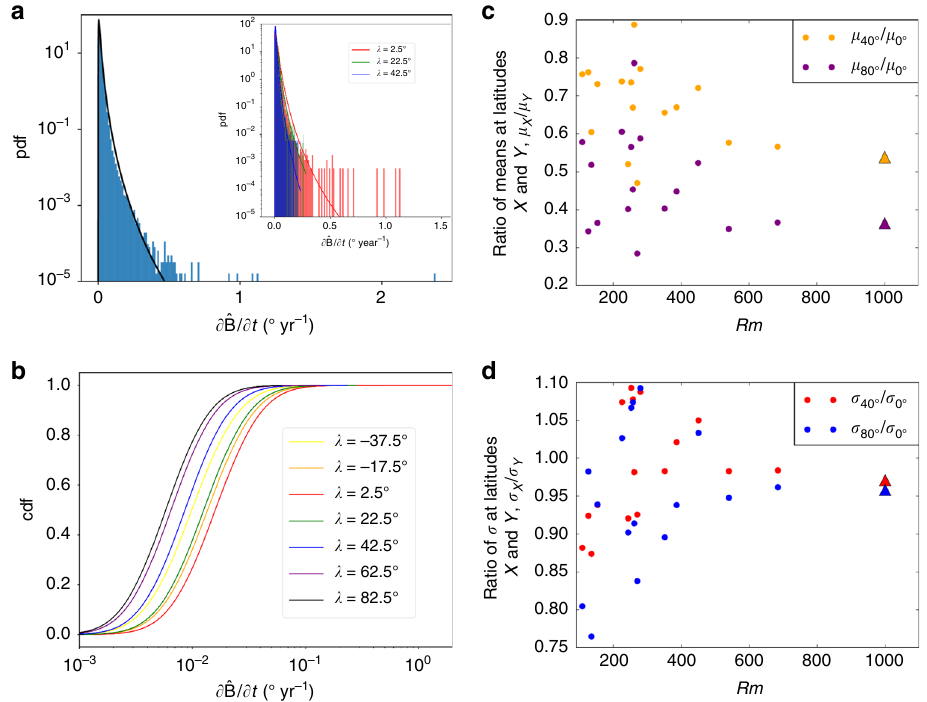
Fig. 3 Statistics of extreme directional magnetic fi eld changes. a Normalised histogram for rates of change of the fi eld vector ^ B in the GGF100k model 25 sampled on a 2° × 2° latitude – longitude grid at 100 year time intervals. The black line shows the fi t of a log-normal probability density function (PDF) to the data with mean μ = 0.009 and standard deviation σ = 0.011. The inset shows histograms at latitudes of 2.5° (red), 22.5° (green) and 42.5° (blue) with PDFs shown as solid lines. b Cumulative distribution functions (CDFs) of ∂ ^ B = ∂ t at different latitudes (shown by colours) from the GGF100k model, showing higher rates of change at lower latitudes. c The ratio of the mean values of PDFs at two different latitudes (denoted by subscripts) for GGF100k and all dynamo simulations as a function of the magnetic Reynolds number Rm. GGF100k is shown at Rm = 1000 as in Fig. 2. Panel d is the same as c but showing ratios of standard